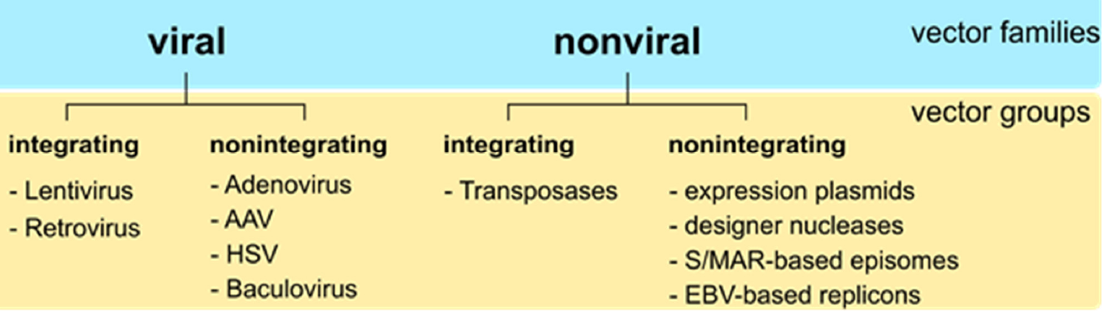
Figure 1. Vector families and vector groups for gene therapy. Vector systems can be classified into families of viral and non-viral vectors. Viral vectors deliver nucleic acids to a variety of cells via transduction. Nonviral vectors are usually delivered using different transfection methods, such as lipofection or electroporation. Both viral and nonviral vectors can be grouped into integrating and nonintegrating vectors. Examples for each vector group are given without any claim of completeness. AAV, Adeno-associated Virus; HSV, Herpes Simplex Virus; S/MAR, scaffold/matrix attachment region; EBV, Eppstein-Barr virus.